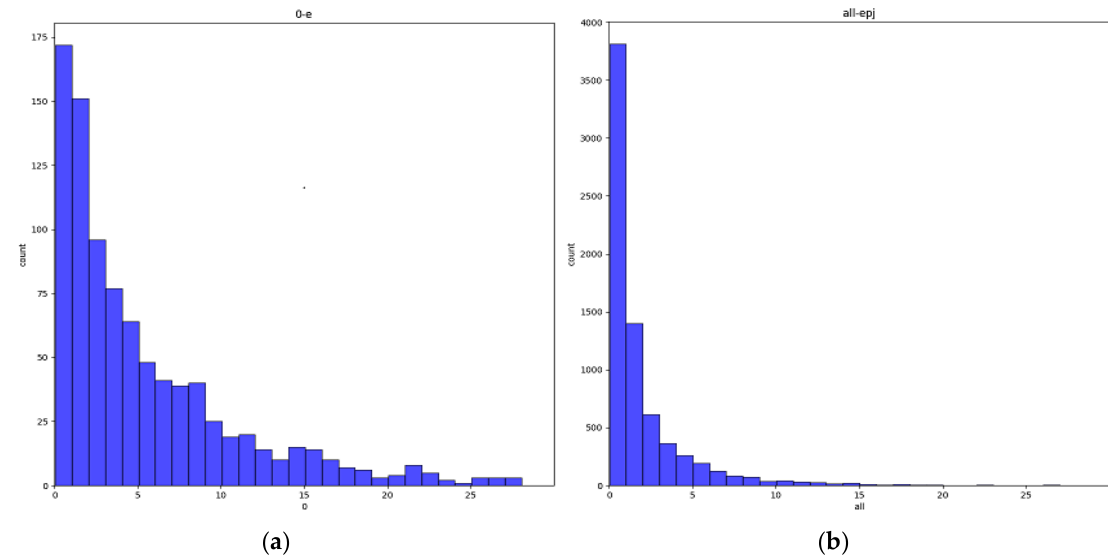
Figure 7. Error distribution of BB3D prediction ( a ) Histogram of the translation error distribution ( b ) Histogram of the pixel projection error distribution. Table 4. Time consumption of bb3d for Q-Net.